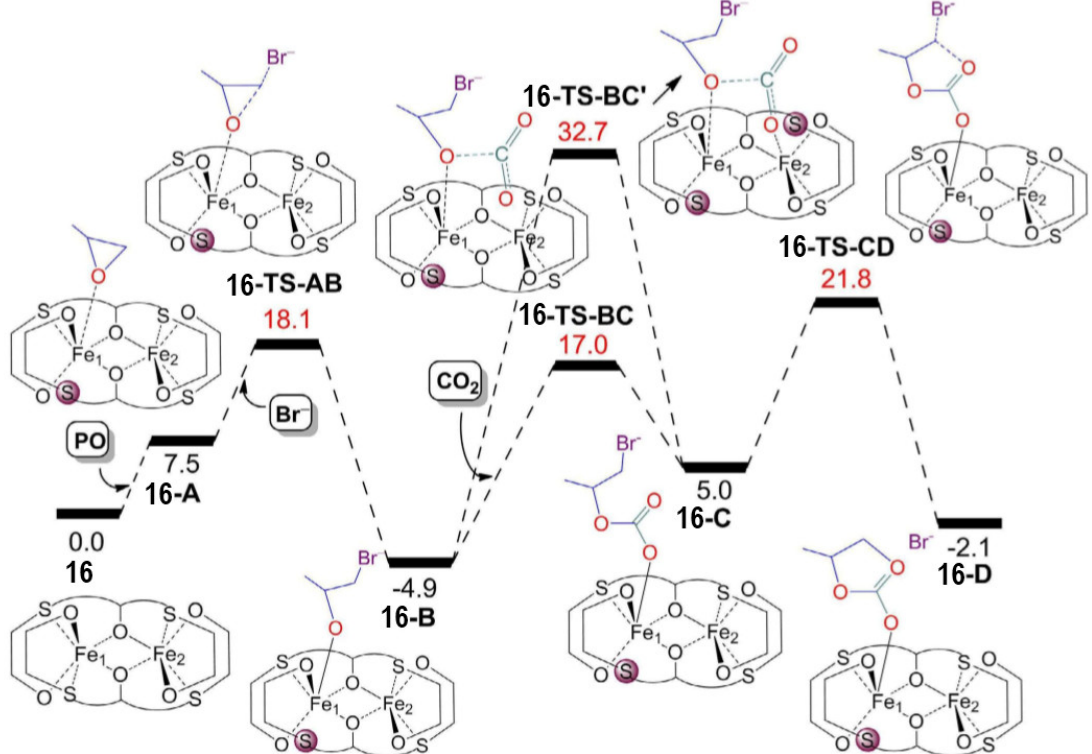
Figure 14. Free energy profile for the coupling of PO and CO 2 promoted by complex 16 [68]. Reprinted with permission from ref. 68. Copyright (2020) John Wiley and Sons.